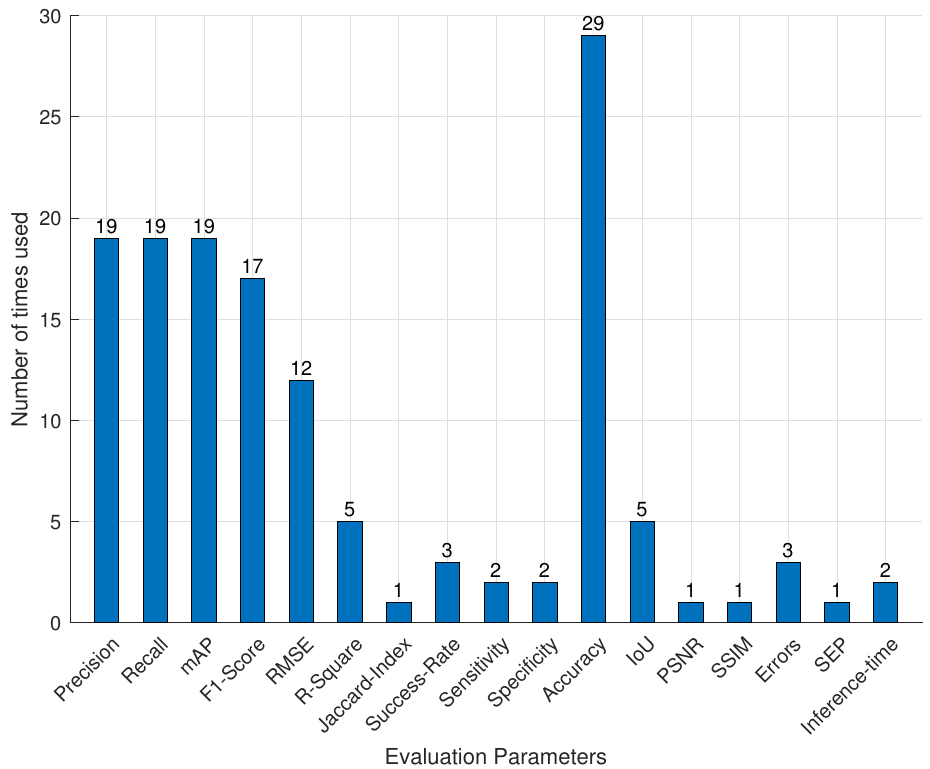
Figure 9. Evaluation parameters distribution of deep learning model in controlled environment